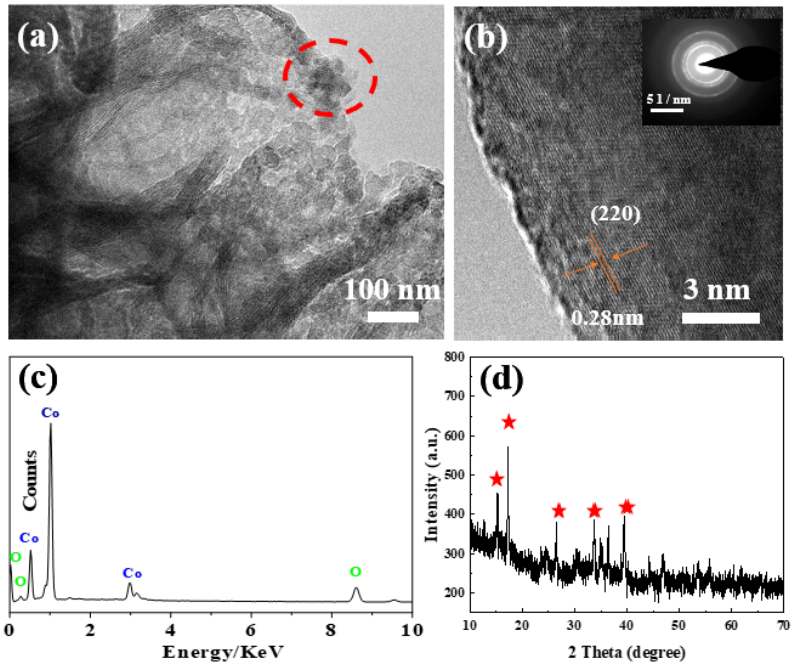
Figure 2. ( a ) TEM images of Co 3 O 4 nanosheets. ( b ) HRTEM images of Co 3 O 4 nanosheets. ( c ) EDS spectra of Co 3 O 4 nanoparticles. ( d ) XRD spectra of Co 3 O 4 nanoparticles. spectra of Co 3 O 4 nanoparticles. ( d ) XRD spectra of Co 3 O 4